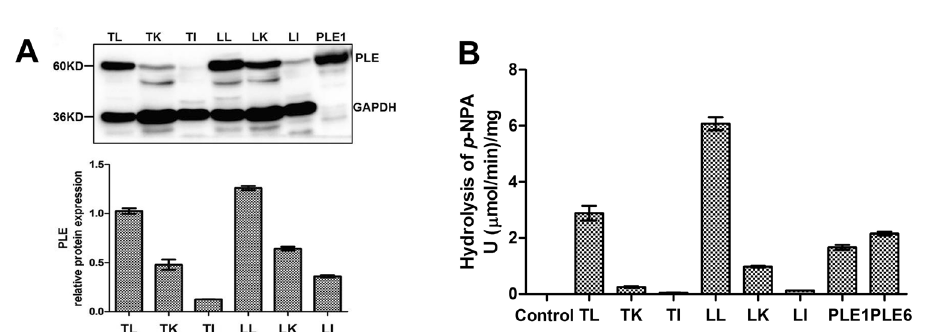
Figure 2. Detection of protein and hydrolytic activities of PLEs and S9 fractions pool. ( A ) Western blotting of PLE in S9 fractions pool (100 μ g) from liver, kidney and intestine (n = 3), positive control was recombinant PLE1 (10 μ g); ( B ) Hydrolytic activity. Substrate p -NPA (200 μ M) were prepared in 990 μ l of reaction buffer Tris- HCl (50 mM, pH 7.4) and then mixed with protein (10 μ g recombinant PLE1 and PLE6 or 100 μ g S9 fractions pool). All assays were performed in triplicate with three transfection experiments and the hydrolytic rates were expressed as the mean ± S.D. (T-Tongcheng, L-Large white/Liver, K-Kidney,